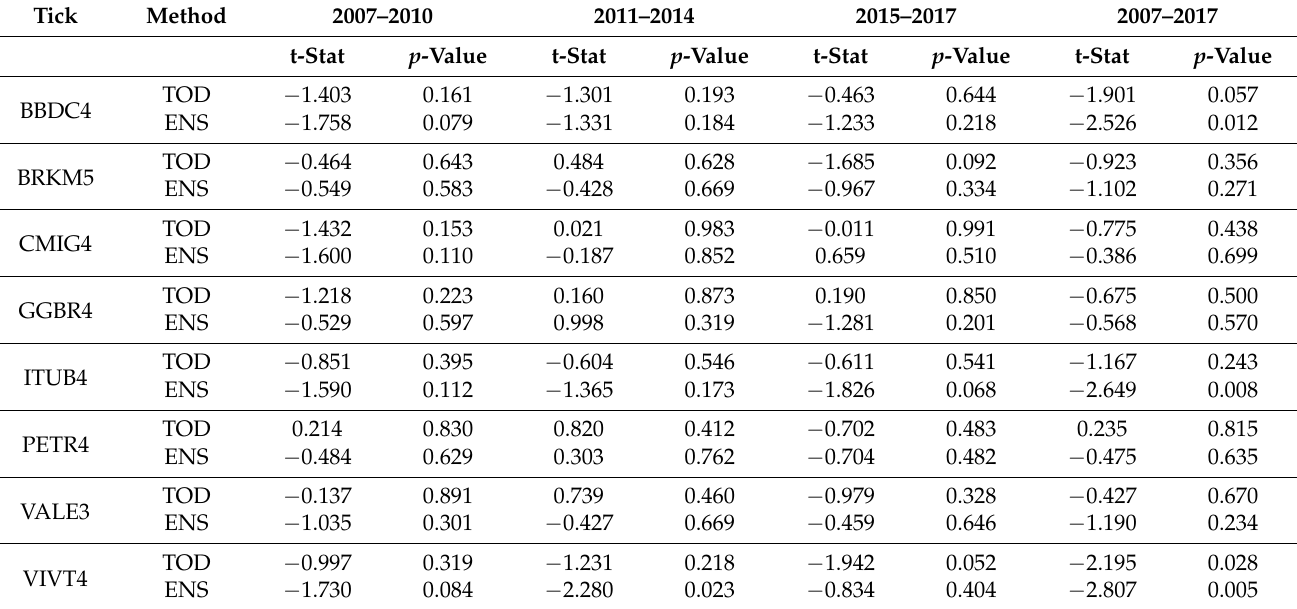
Table 1. Statistics of difference between the average return for a trading system (TS) and the buy and hold (B&H). (By the